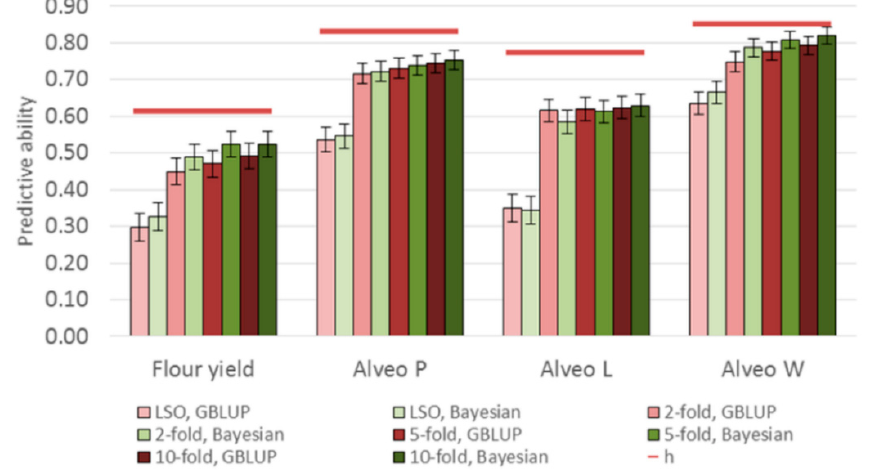
Figure 6. Comparison of predictive abilities based on GBLUP and Bayesian Power Lasso models. Red lines are the square root of narrow-sense genomic heritabilities (h) for each trait based on the GBLUP models.